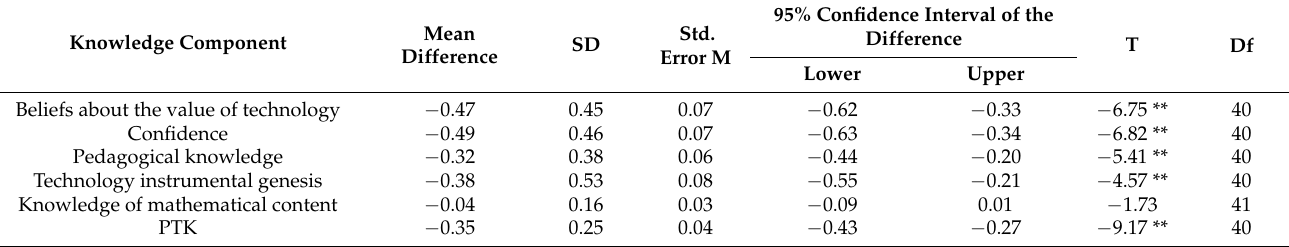
Table 3. Paired-samples t -test between participants’ scores before and after PD